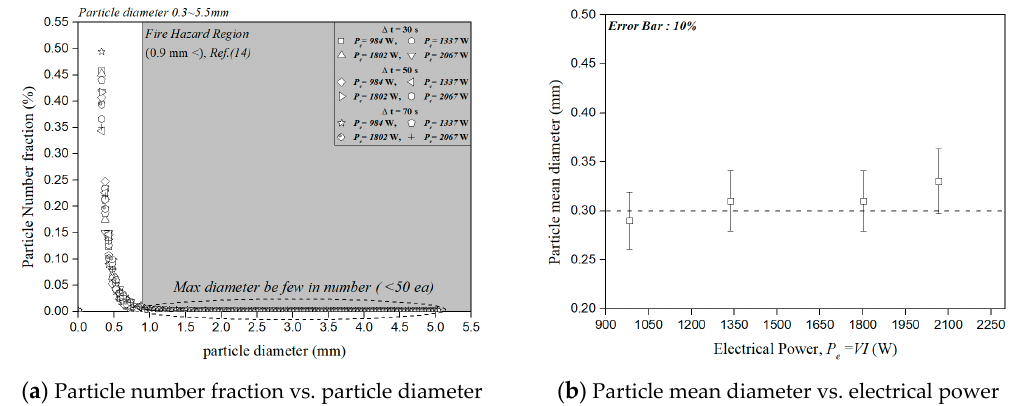
( a ) Particle number fraction vs. particle diameter ( b ) Particle mean diameter vs. electrical power Figure 7. Results of the ( a ) fraction of particle number, and ( b ) particle mean diameter when P e = 984, 1337, 1802, and 2067 W and Δ t = 30 s, 50 s, and 70 s.